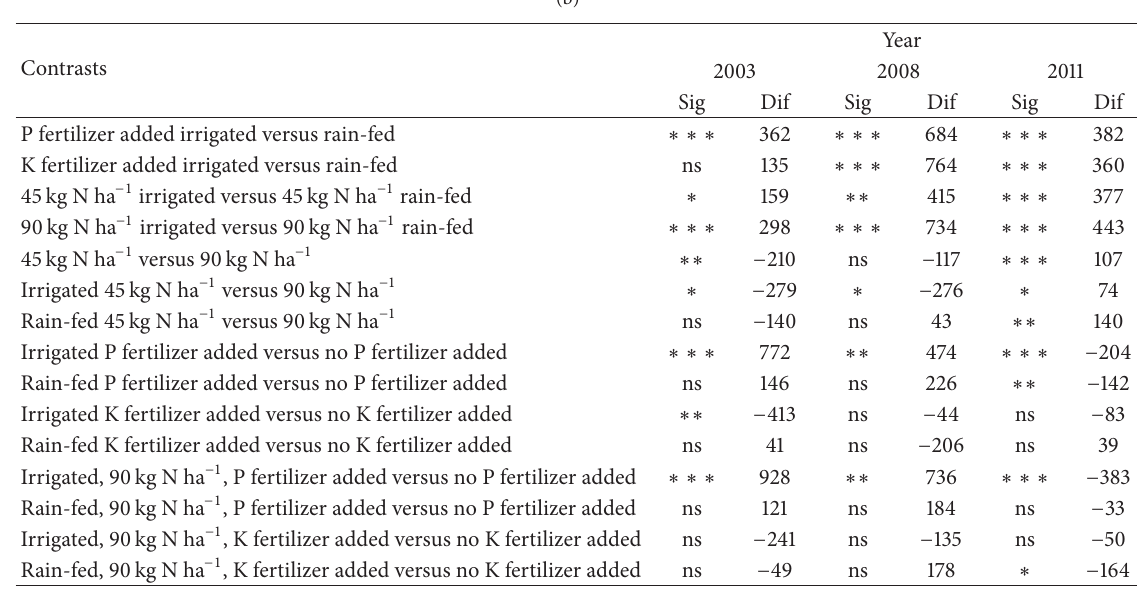
a Standard error of the difference for the interaction of fertilizer treatment and water treatment. ∗ , ∗∗ , and ∗ ∗ ∗ are significant at the 0.1, 0.01, and 0.001 level, respectively. ns: not significant at the 0.1